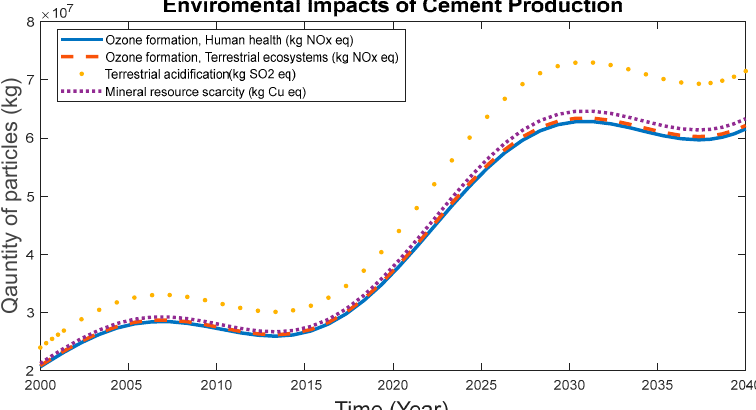
Figure 6. Plot showing a possible long-term environmental impact of cement production in South Africa. Ozone formation, human health measured in kg NOx eq, ozone formation, terrestrial ecosystems measured in kg NOx eq, terrestrial acidification measured in kg SO2 eq and mineral resource scarcity measured in kg Cu eq.